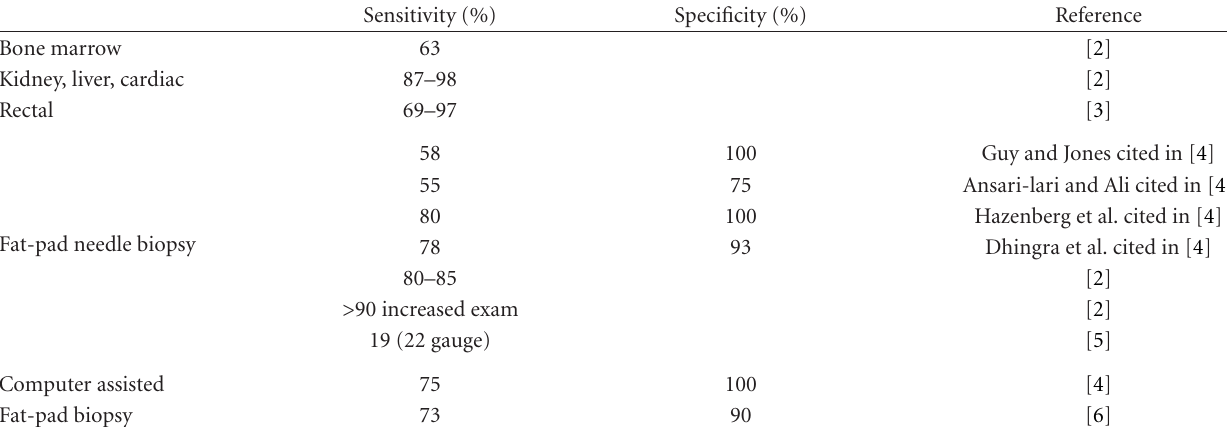
Table 1: Sensitivity and specificity of Congo red staining for amyloidosis related to tissue